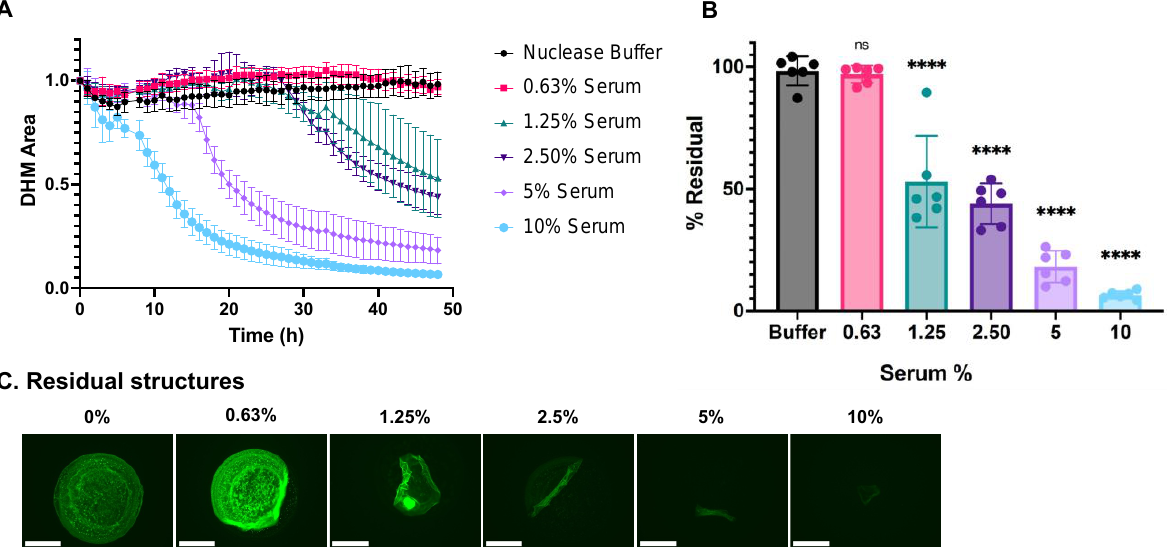
Figure 4. DHM degradation by normal human serum. ( A ) Kinetic curves of the dose-dependent DHM degradation by human serum. ( B ) End-point degradation of DHMs by serum comparing the final and initial amounts of DHMs. DHM residuals were compared with the control group, nuclease buffer, by one-way ANOVA, ns = not significant, and **** p < 0.0001. ( C ) Residual structures visualized with fluorescent microscopy after 24-h incubation with a serum concentration series. Structures were stained with SYTOX Green. The scale bar is 275 μ m.